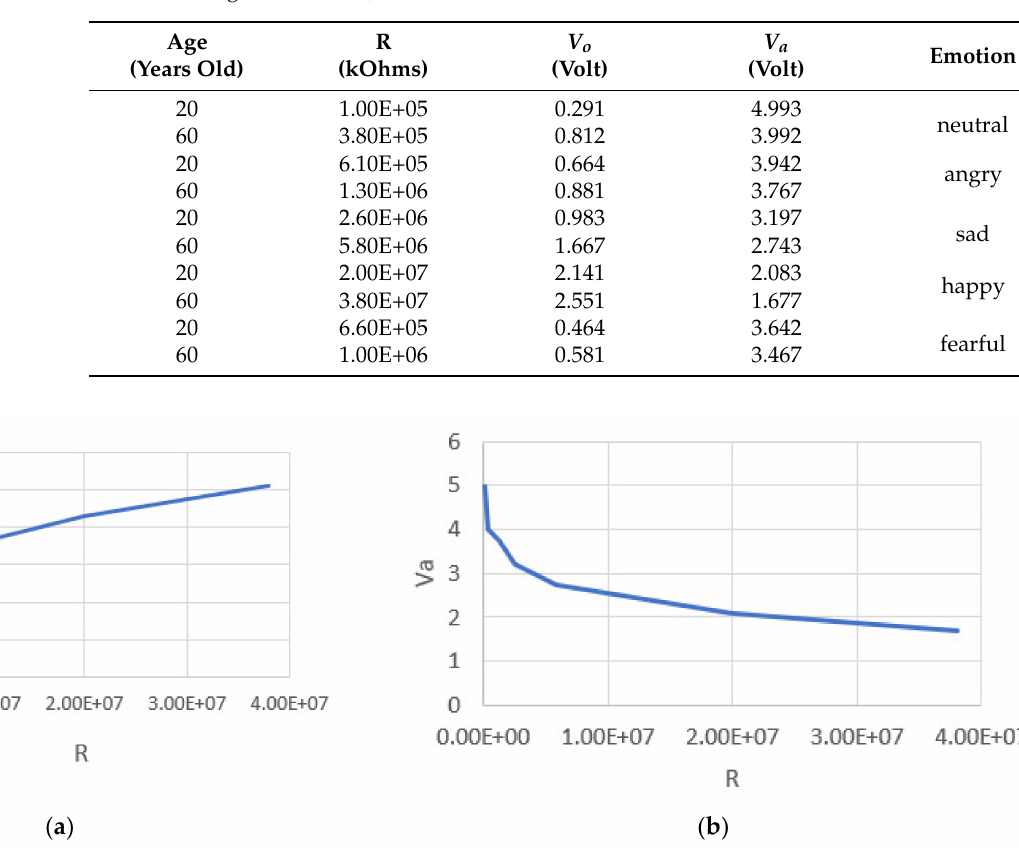
Table 4. Change in V a and V o based on emotions.